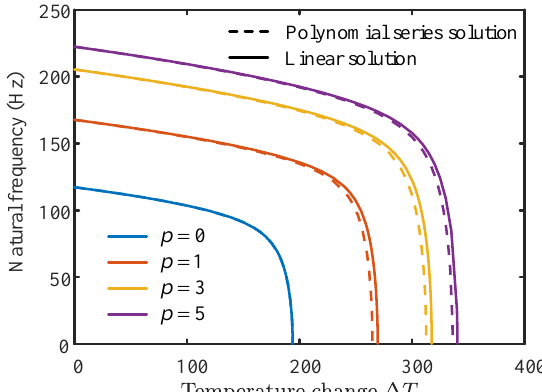
Figure 3. The influence of temperature change on the natural frequency of a conical shell under different volume fraction indices.